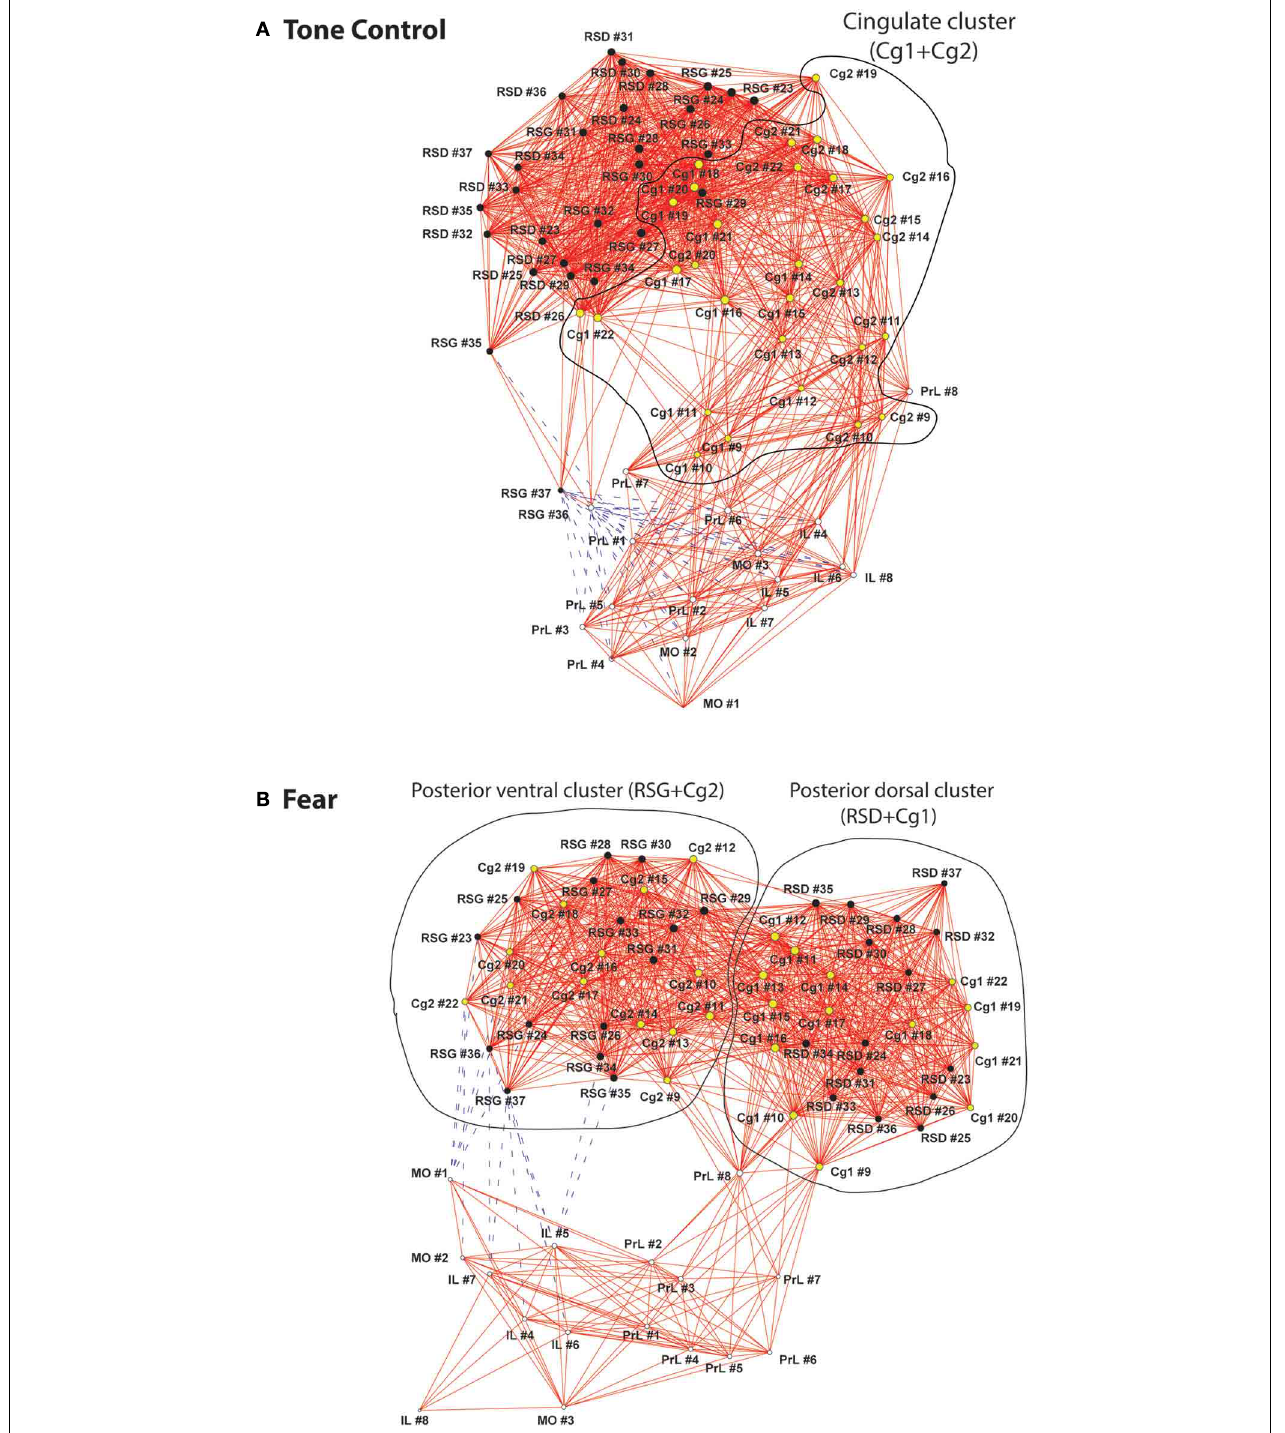
FIGURE 4 | Graph theoretical analysis of the functional networks of the cortical midline structures. (A) In the control mice, relative location of regions of interest (ROIs) along the anterior-posterior axis was largely preserved topologically in the functional network. The cingulate cluster, which is circled and highlighted in yellow, connected anterior and posterior aspects of the cortical midline structures (CMS). (B) The fear-conditioned mice